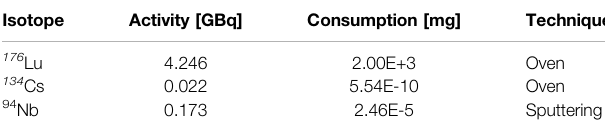
TABLE 3 | List of elements selected for the fi rst day